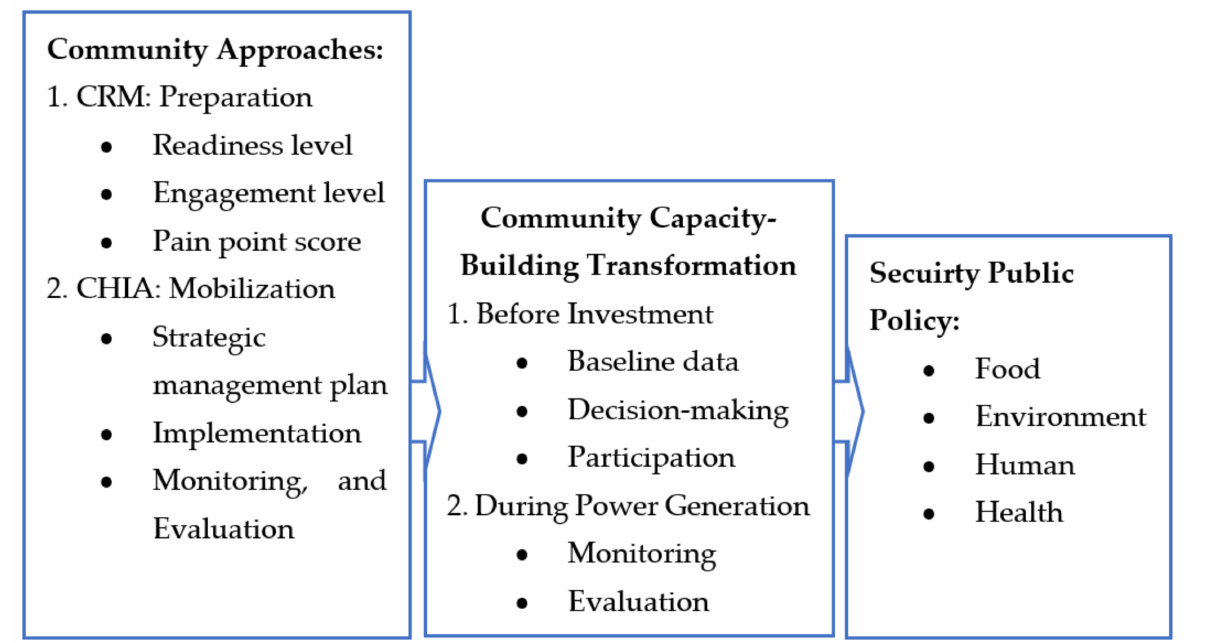
Figure 1. A Framework for community mobilization to promote public policy. (1) CRM serves the fundamental status of the community, such as readiness, engagement, and impact-related pain point